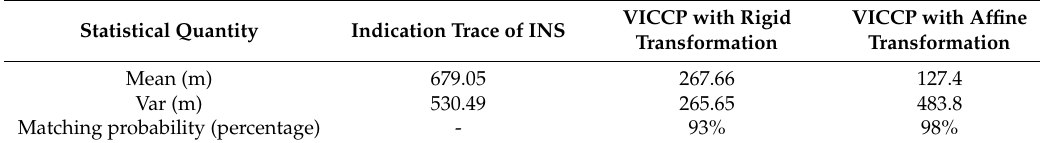
Table 3. Comparison of ICCP and VICCP with 100 times Monte Carlo simulation.